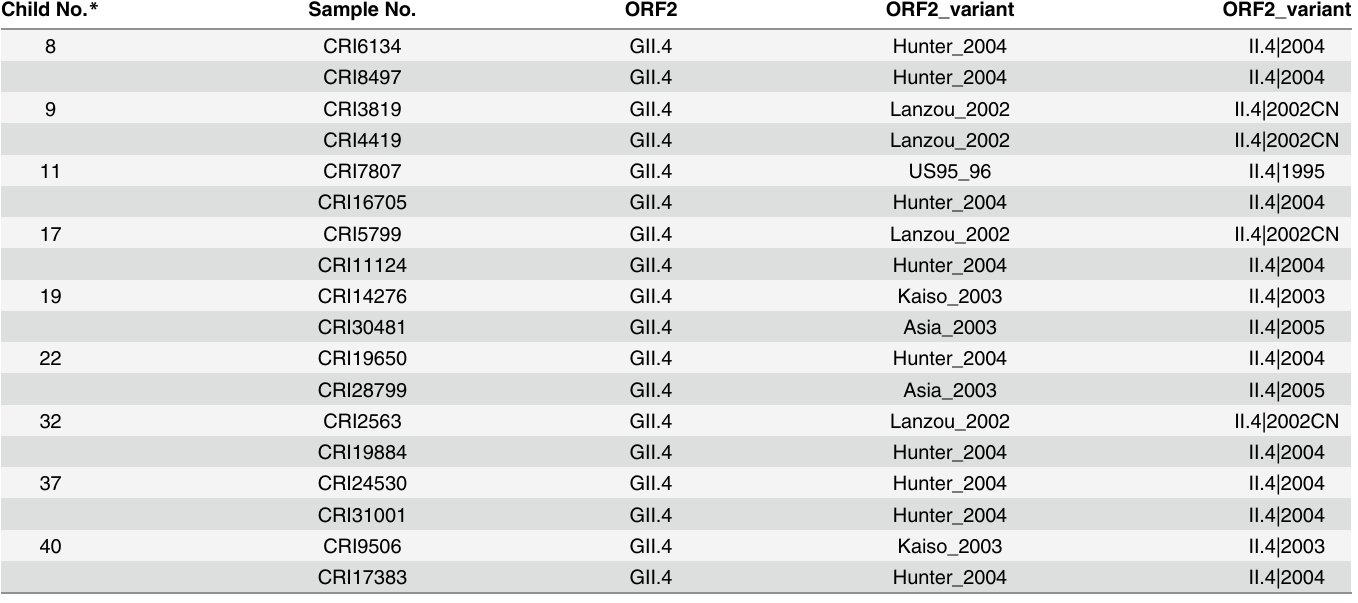
Table 2. Distribution of norovirus variants of GII.4. Child No. *